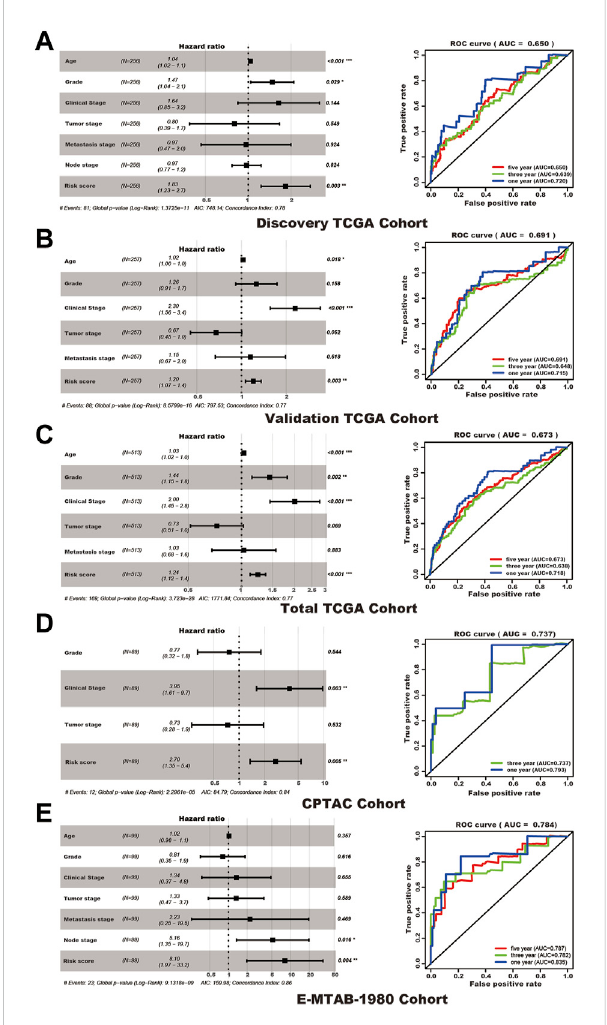
FIGURE 4 The SUMOylation risk score is an independent poor prognosis factor of kidney cancer patients. In each sub fi gure, the left panel shows the multivariate cox regression results, and the right panel presents the receiver operating characteristic curve of 1, 3, and 5 years (the 1 and 3 years of the CPTAC cohort). (A) Discovery